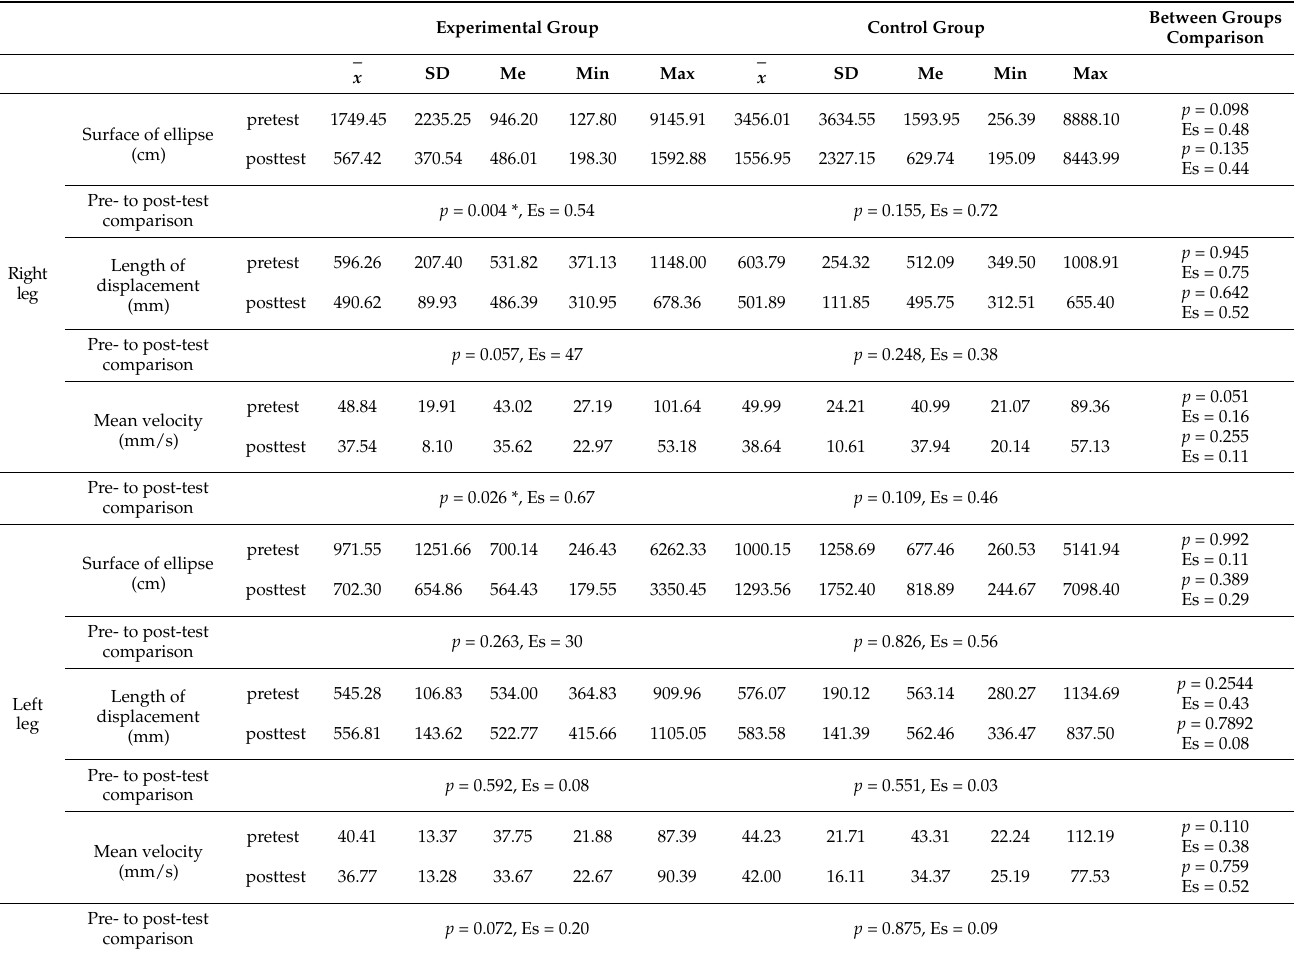
Table 4. Results of balance assessment during one-leg stand on a Freestep platform. Experimental Group Control Group Between Groups